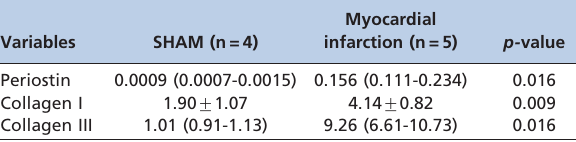
Table 4 - Levels of myocardial periostin and collagen types I and